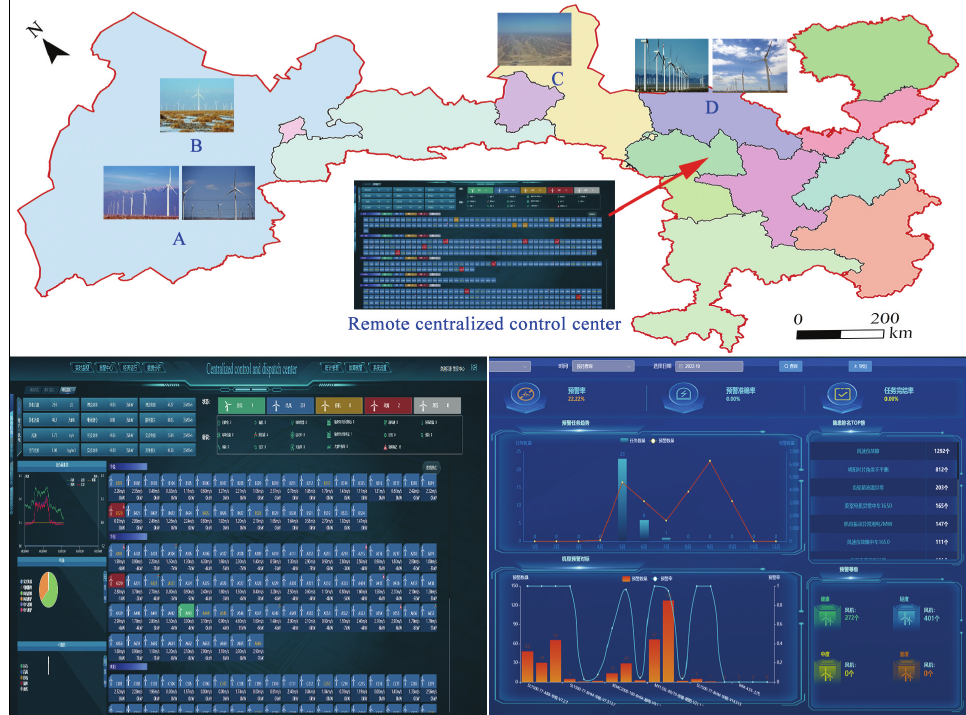
Figure 12. Industrial field applications.